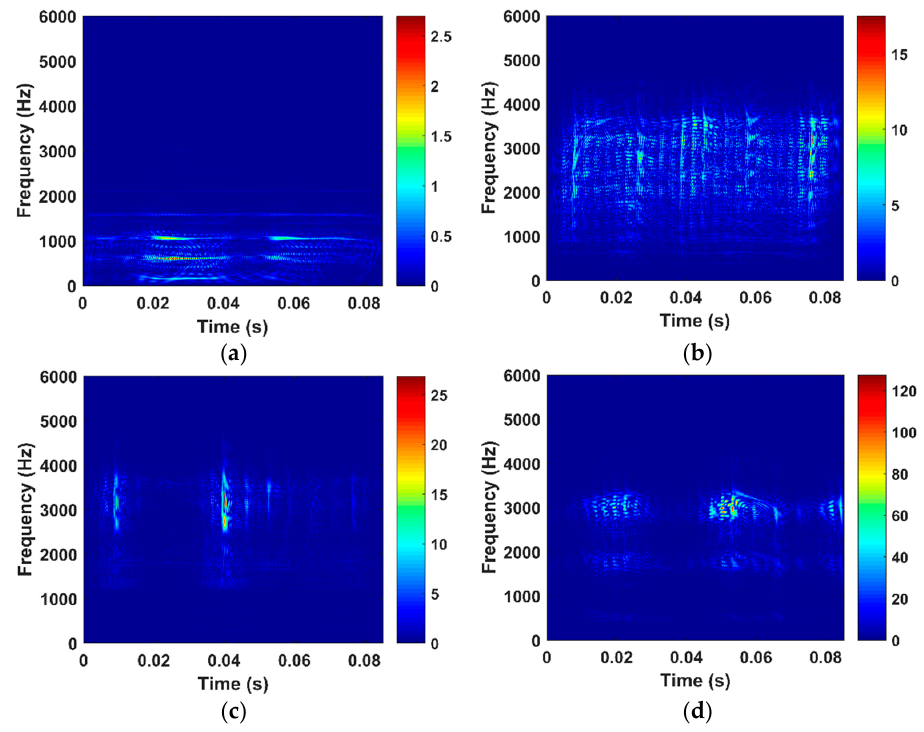
Figure 9. TFIs obtained using the PWVD from bearing vibration signals of different severity degrees: